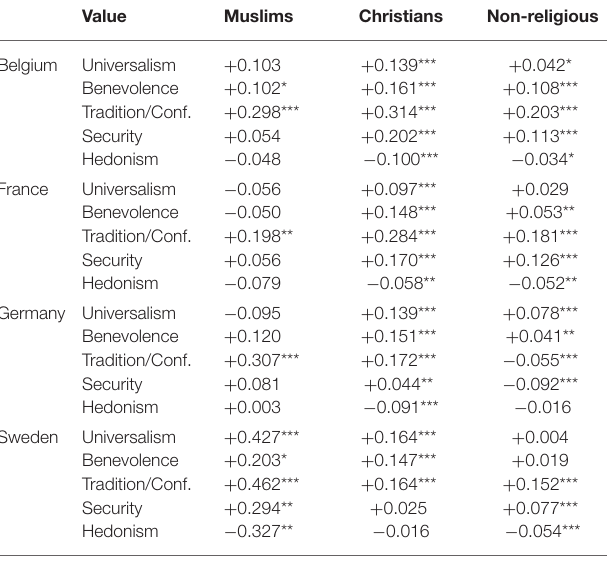
TABLE 6 | Standardized effects of religiosity on values. Value